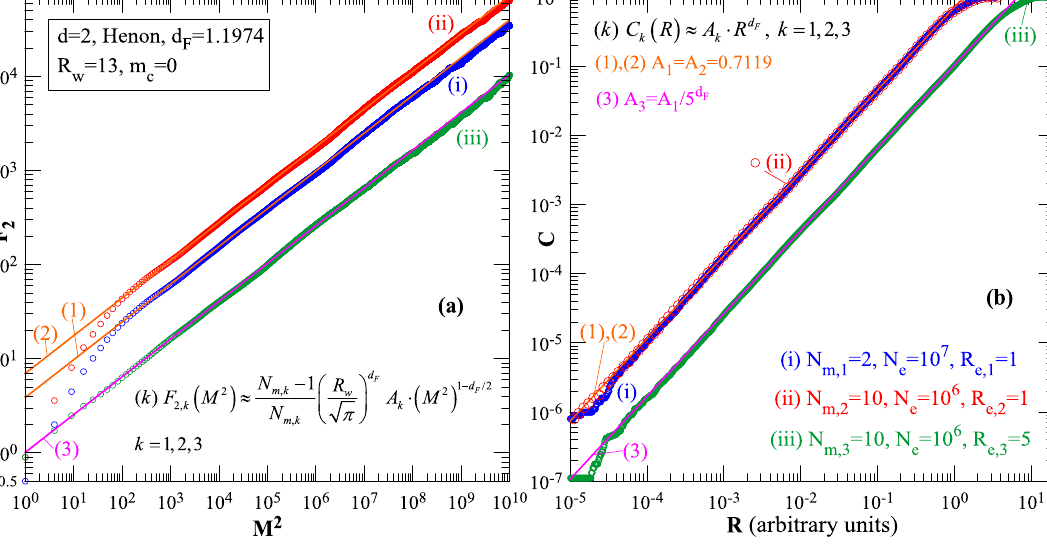
Fig. 13 Analysis of Henon data sets. Case (i) involves N e = 10 7 events with multiplicity N m , 1 = 2. In similar manner case (ii) corresponds to N e = 10 6 and N m , 2 = 10. Case (iii) is similar to case (ii) but the points are expanded in space by a factor R e , 3 =